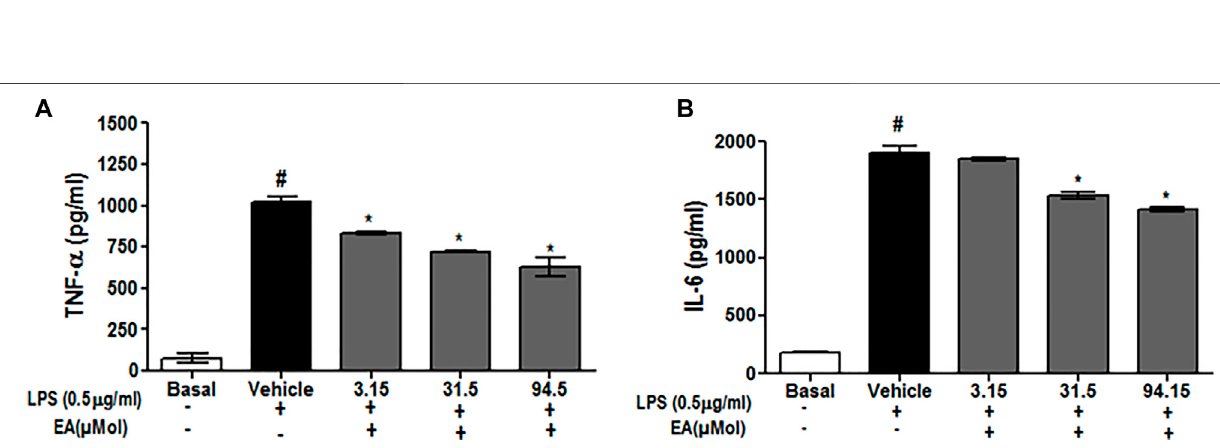
Frontiers in Pharmacology |